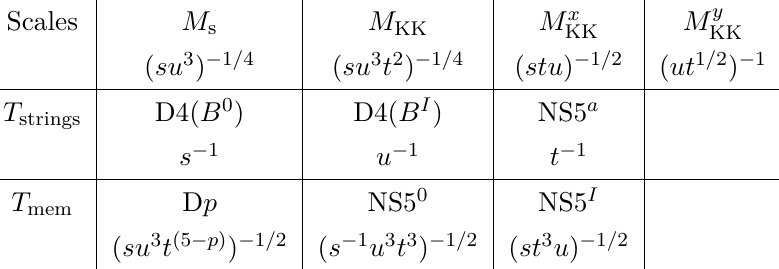
Table 1 . Masses and tensions of KK states and branes in an isotropic Z 2 × Z 0 in Planck units.